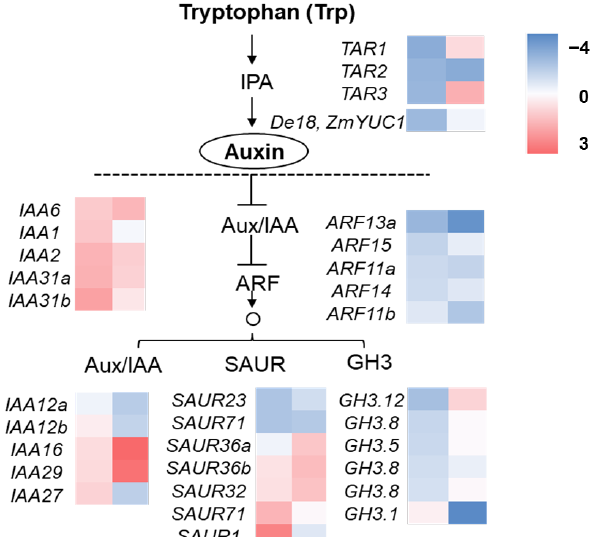
Figure 6. Heat maps of DEGs enriched in IAA synthesis and signaling functions. The color bar indicates the log2 (fold change) values from small to large. The left-side color bar represents 12 DAP, the right-side color bar represents 20 DAP.